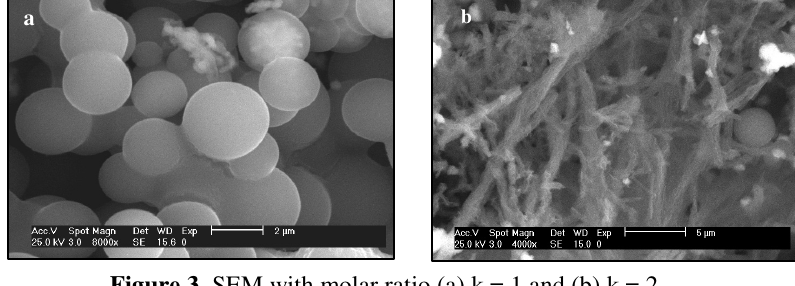
Figure 3. SEM with molar ratio (a) k = 1 and (b) k = 2